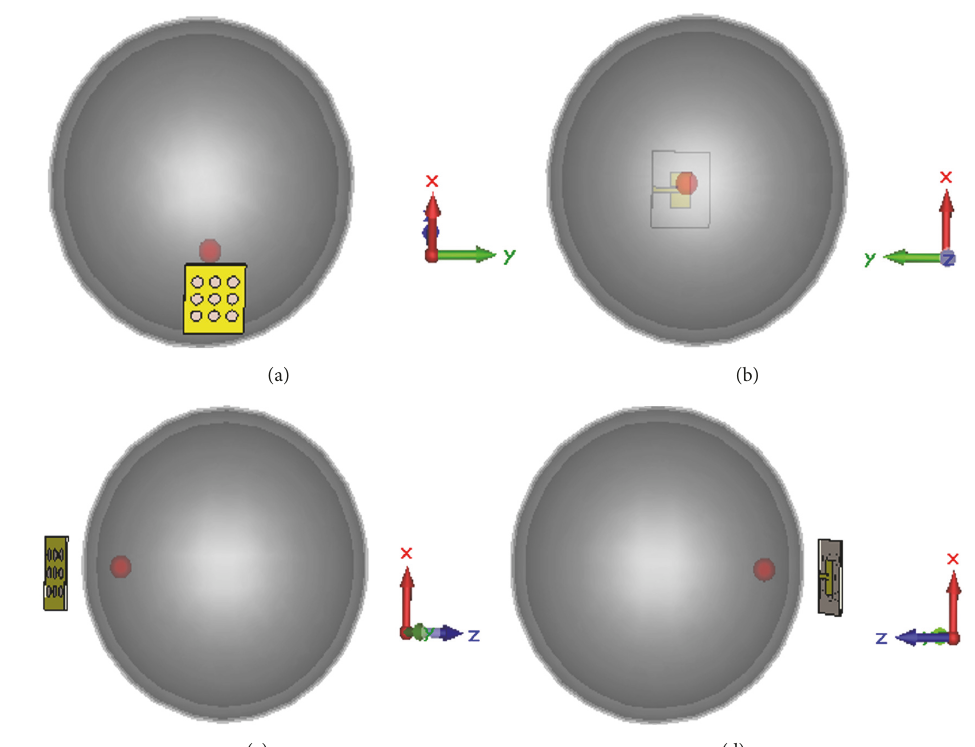
Figure 11: Position of antenna for scanning the phantom in (a) 𝑥 - 𝑦 plane, (b) reverse 𝑥 - 𝑦 plane, (c) 𝑥 - 𝑧 plane, and (d) reverse 𝑥 - 𝑧